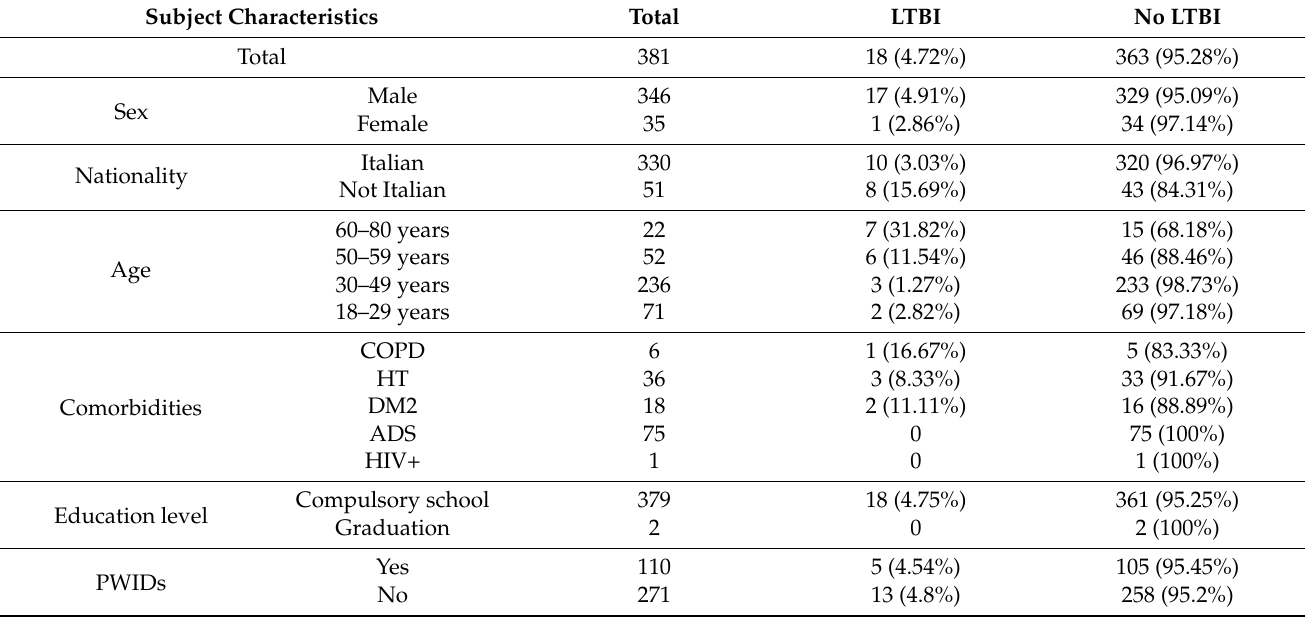
Table 3. Frequency of each variable among the LTBI-positive group and LTBI-negative group. ADS indicates anxious-depressive syndrome; COPD, chronic obstructive pulmonary disease; DM2, type 2 diabetes mellitus; HIV, human immunodeficiency virus; HT, hypertension; LTBI, latent tuberculosis infection; PWIDs, people who inject